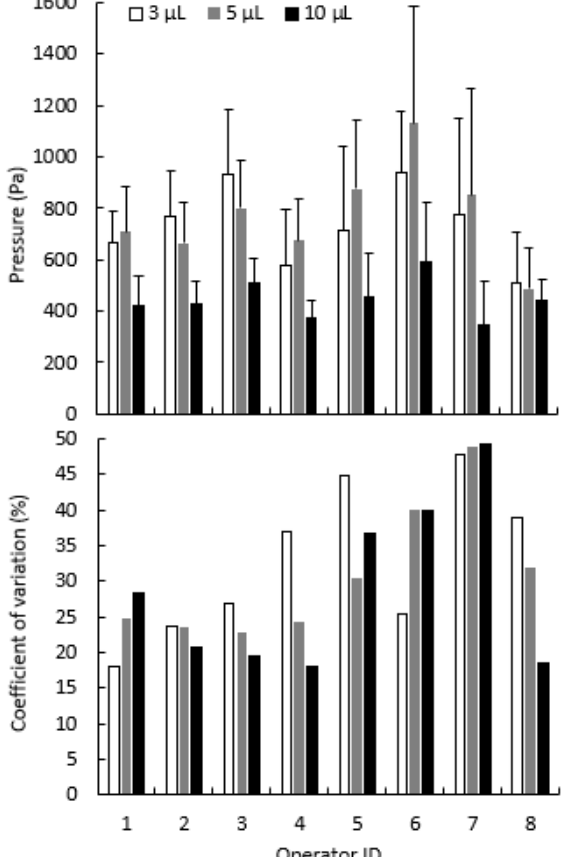
Figure 4. Peak pressure ( upper panel ) and variability ( lower panel ) generated during mouth-pipet- ting among eight operators when asked to simulate injection of samples into small-bodied live- bearing fishes. Bars represent standard deviation.